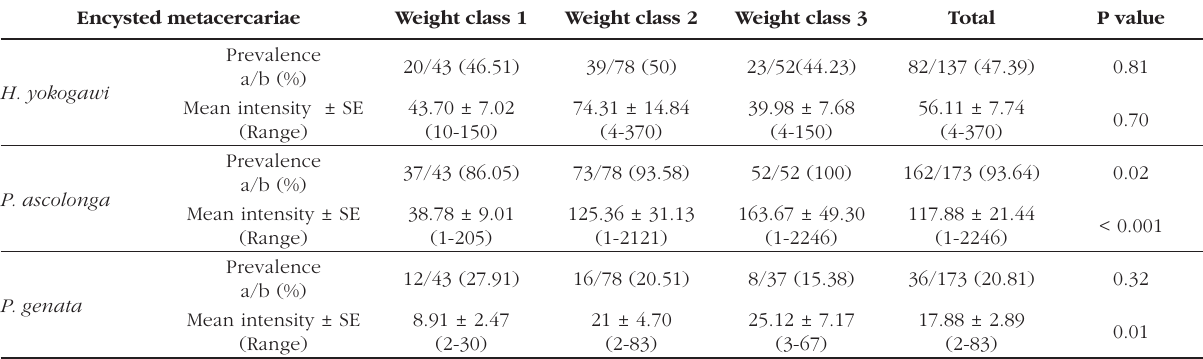
Table III. – Prevalence (%) and mean intensity (± SE) of heterophyid encysted metacercariae (MC) in T. zilli per host weight class.